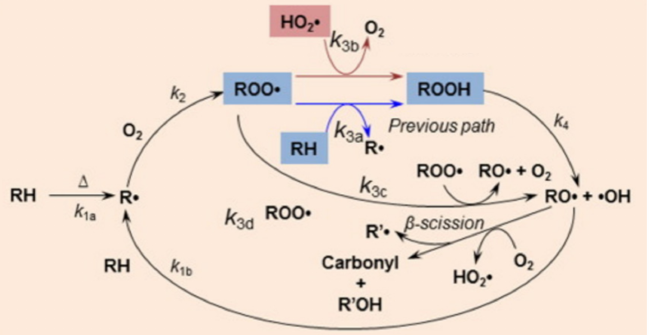
Figure 2. Auto-oxidation scheme of polymer. Reprinted from Ref. [68]. Copyright (2016), with permission from Elsevier.